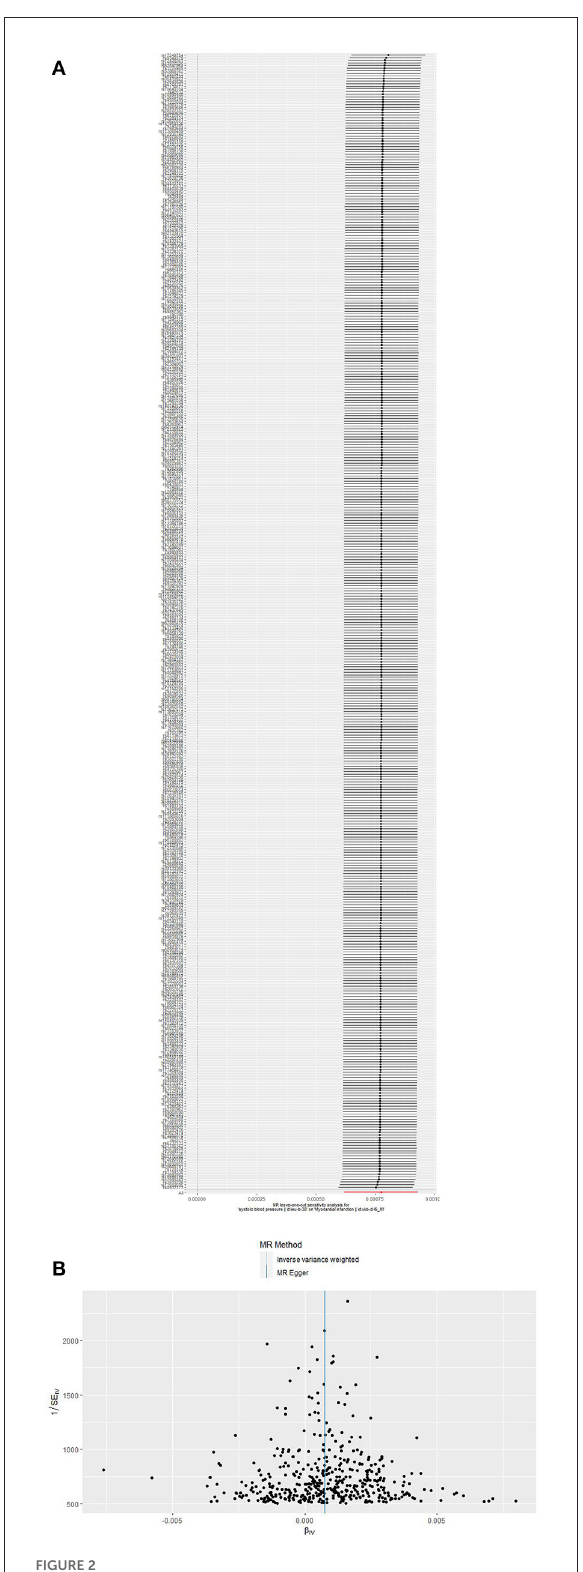
FIGURE2 (A,B) Leave-one-out sensitivity method and funnel plots in the SBP → MI MR analysis. (A) Leave-one-out sensitivity